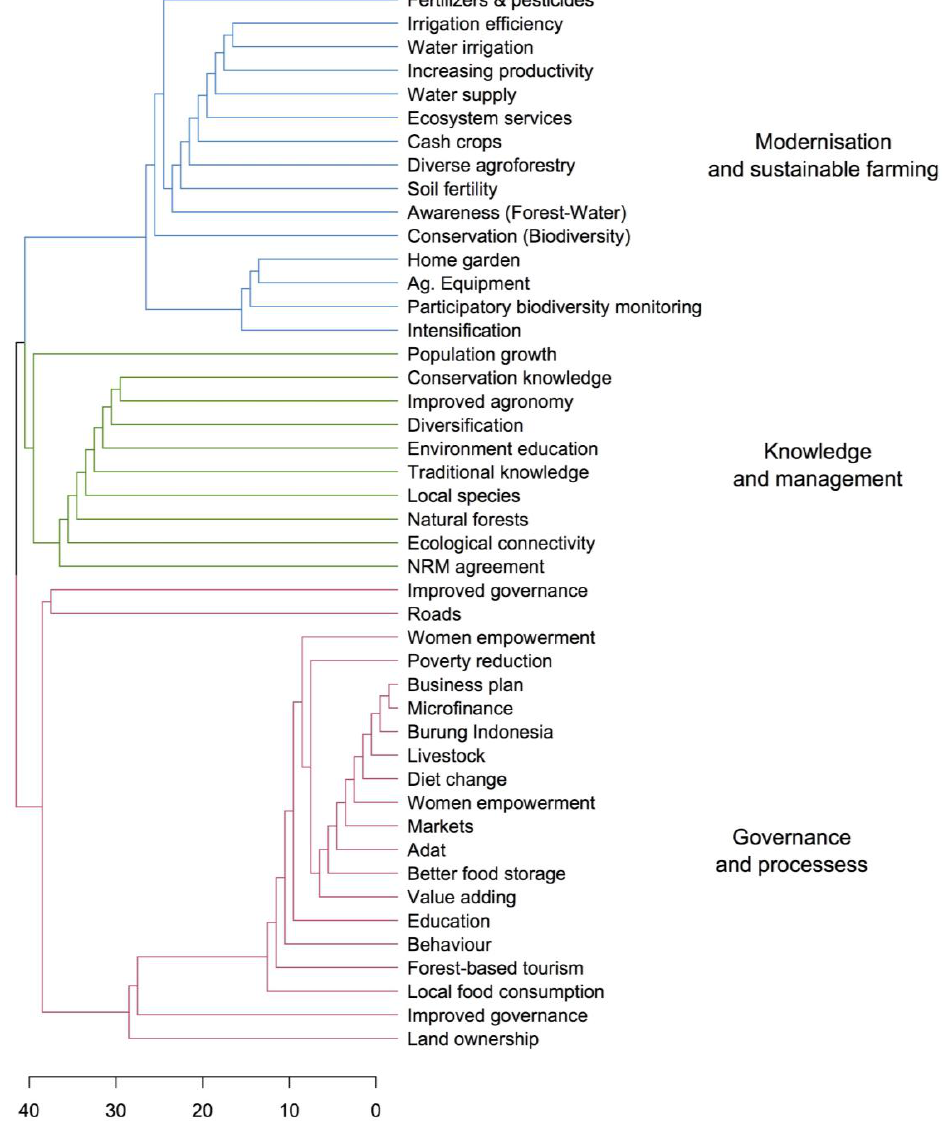
Figure 5. The Mbeliling food security and biodiversity conservation nexus network represented as a dendrogram. The dendrogram shows the node names at the tips of the branches of the ‘tree’. The relationships between nodes are represented by the distances between them. The nodes are classified into clusters based on the fastgreedy algorithm, and shown as different coloured branches. (1) Modernisation and sustainable farming; (2) Knowledge and management; and (3) Governance and processes.